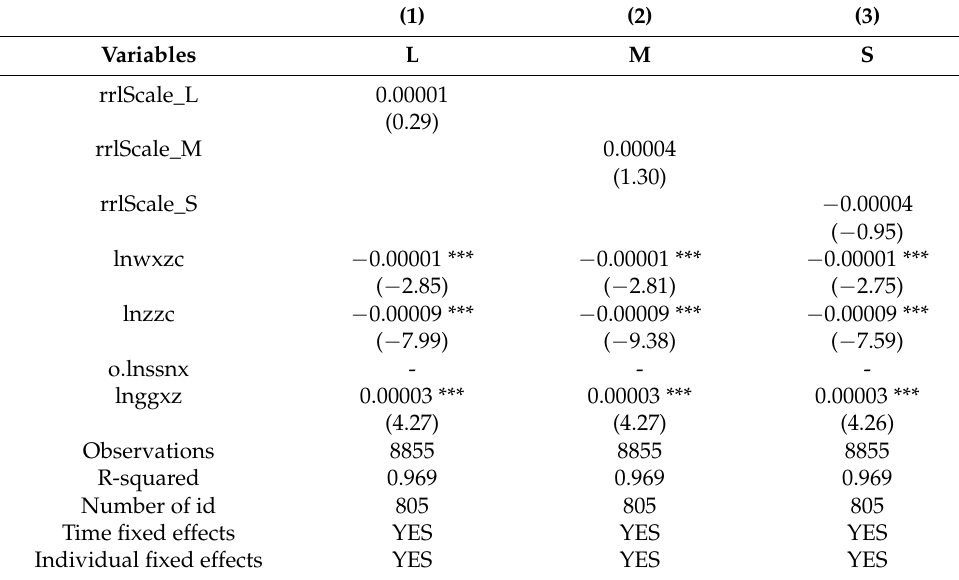
Table 10. Heterogeneity analysis on enterprise scale based on Iv